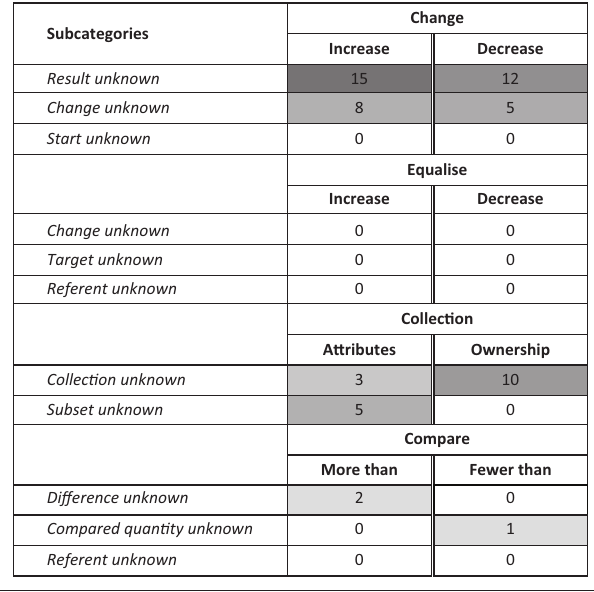
FIGURE 15: Frequency of different types of word problems across three